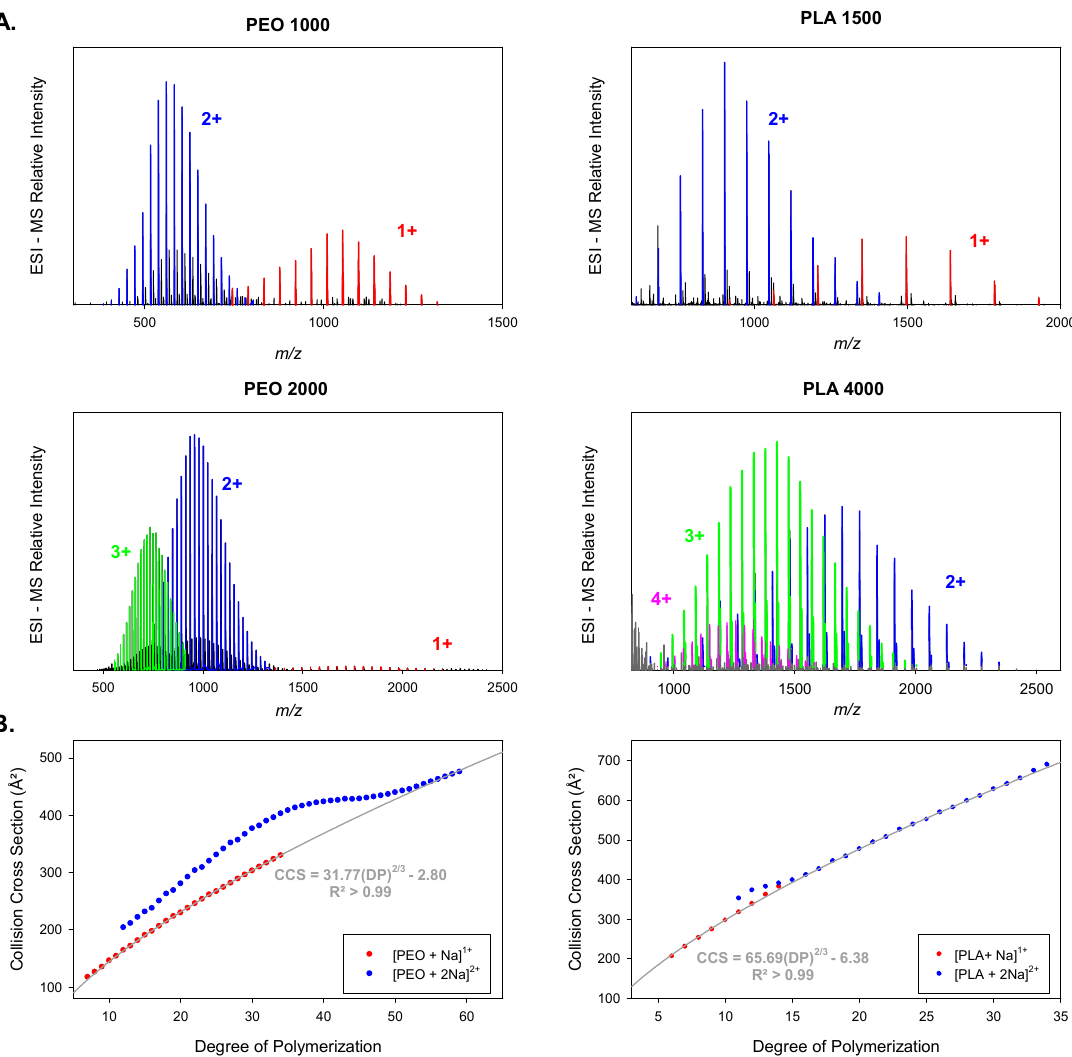
Figure 2. ( A ) Electrospray (ESI) Mass spectra of α -methyl, ω -hydroxy-Poly(ethylene oxide) (PEO) 1000, poly(L-lactide) (PLA) 1500, PEO 2000, and PLA 4000. Detected ion series with di ff erent charge states, 1 + , 2 + , 3 + , and 4 + are highlighted in di ff erent colors. ( B ) Collision cross section evolution of singly and doubly charged PEO and PLA ions as a function of the degree of polymerization (DP). Fittings of the data corresponding to globular structures (singly charged and doubly charged beyond the plateau) are shown in dark grey along with fitting equations and regression coefficients.